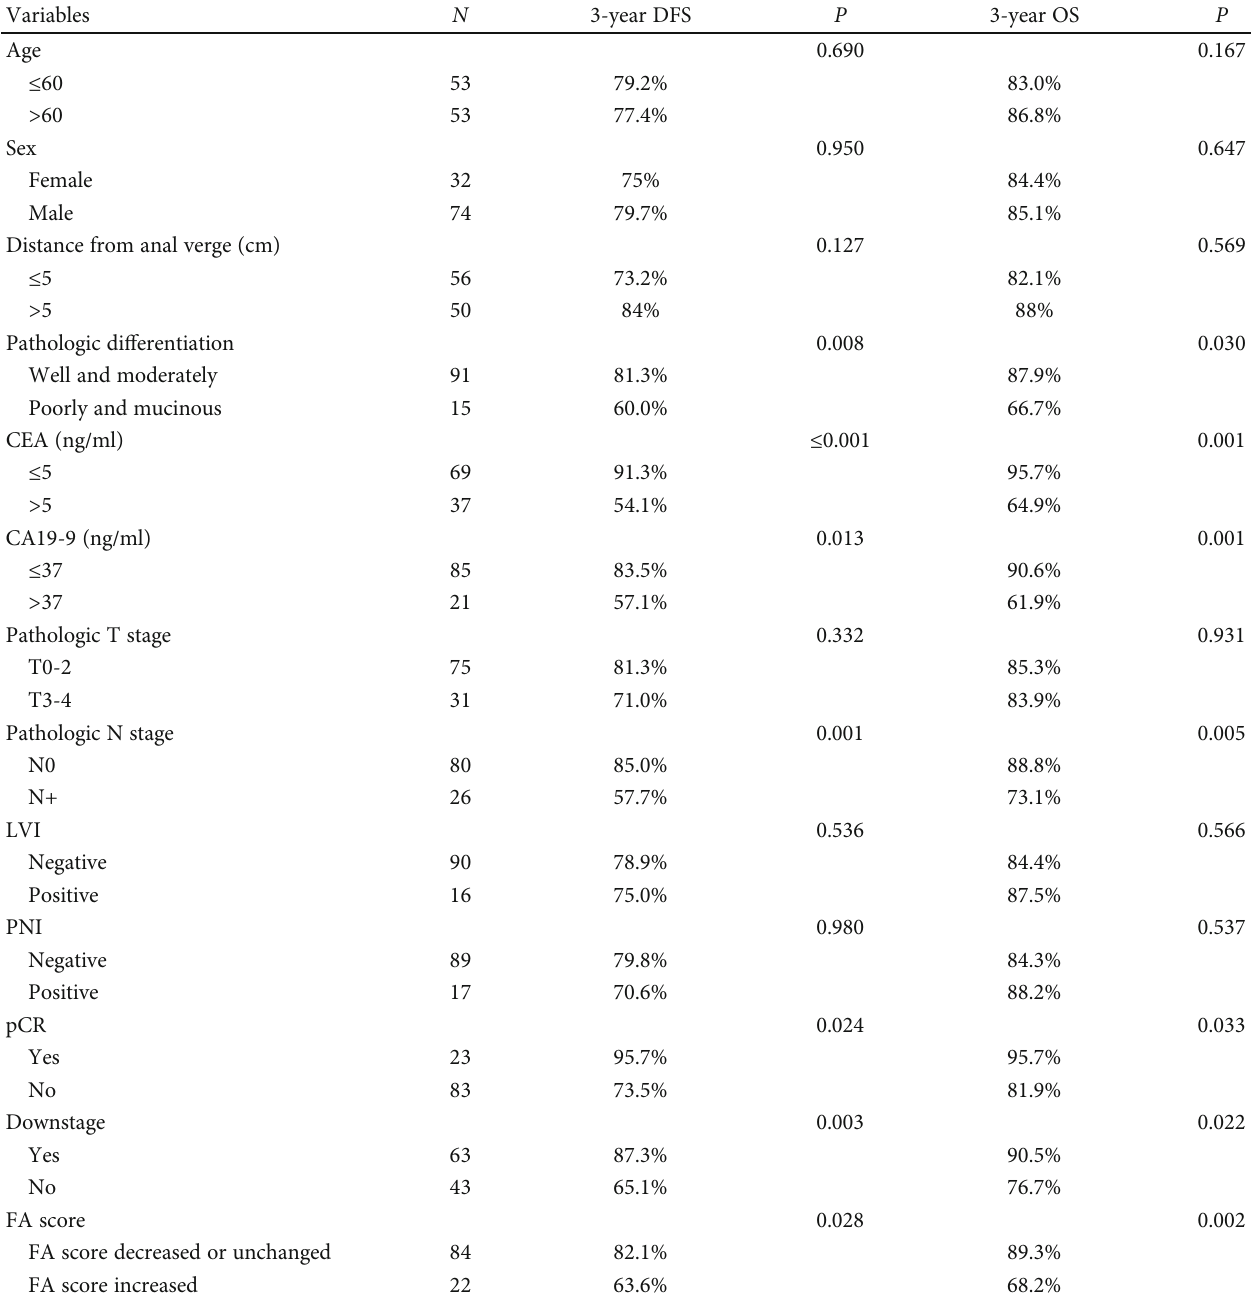
Table 3: Univariate analysis for 3-year DFS and OS